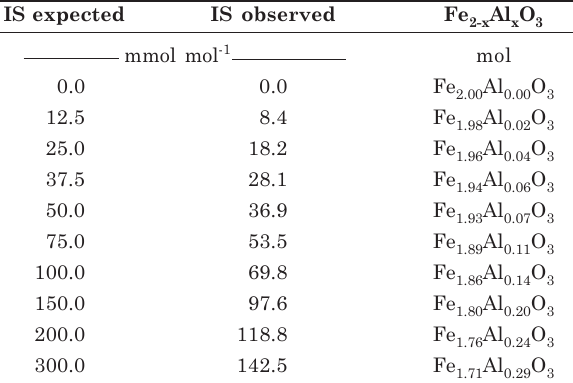
Table 1. Isomorphic substitution (IS) of Fe for Al